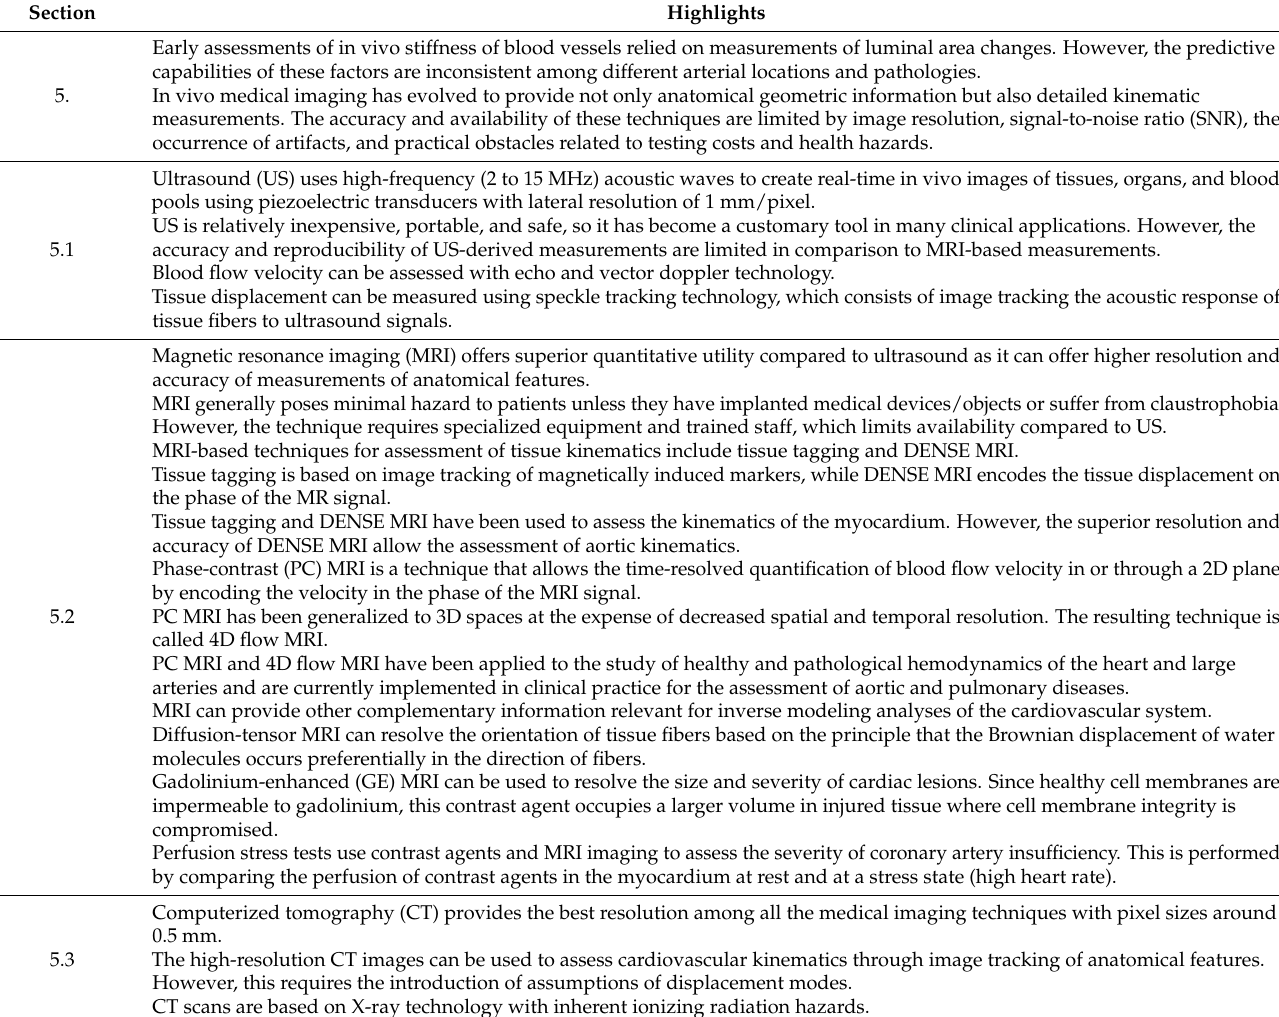
Table 6. Summary of medical imaging-based